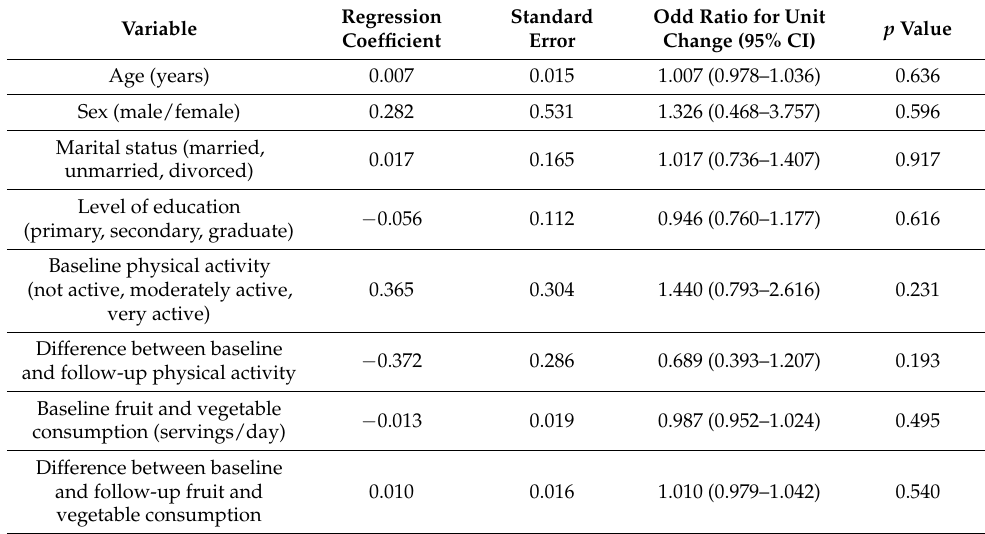
Table 7. Multiple logistic regression analysis of the influence of some clinical prognostic variables on changes in the waist circumference (loss vs. gain) of the study population at follow